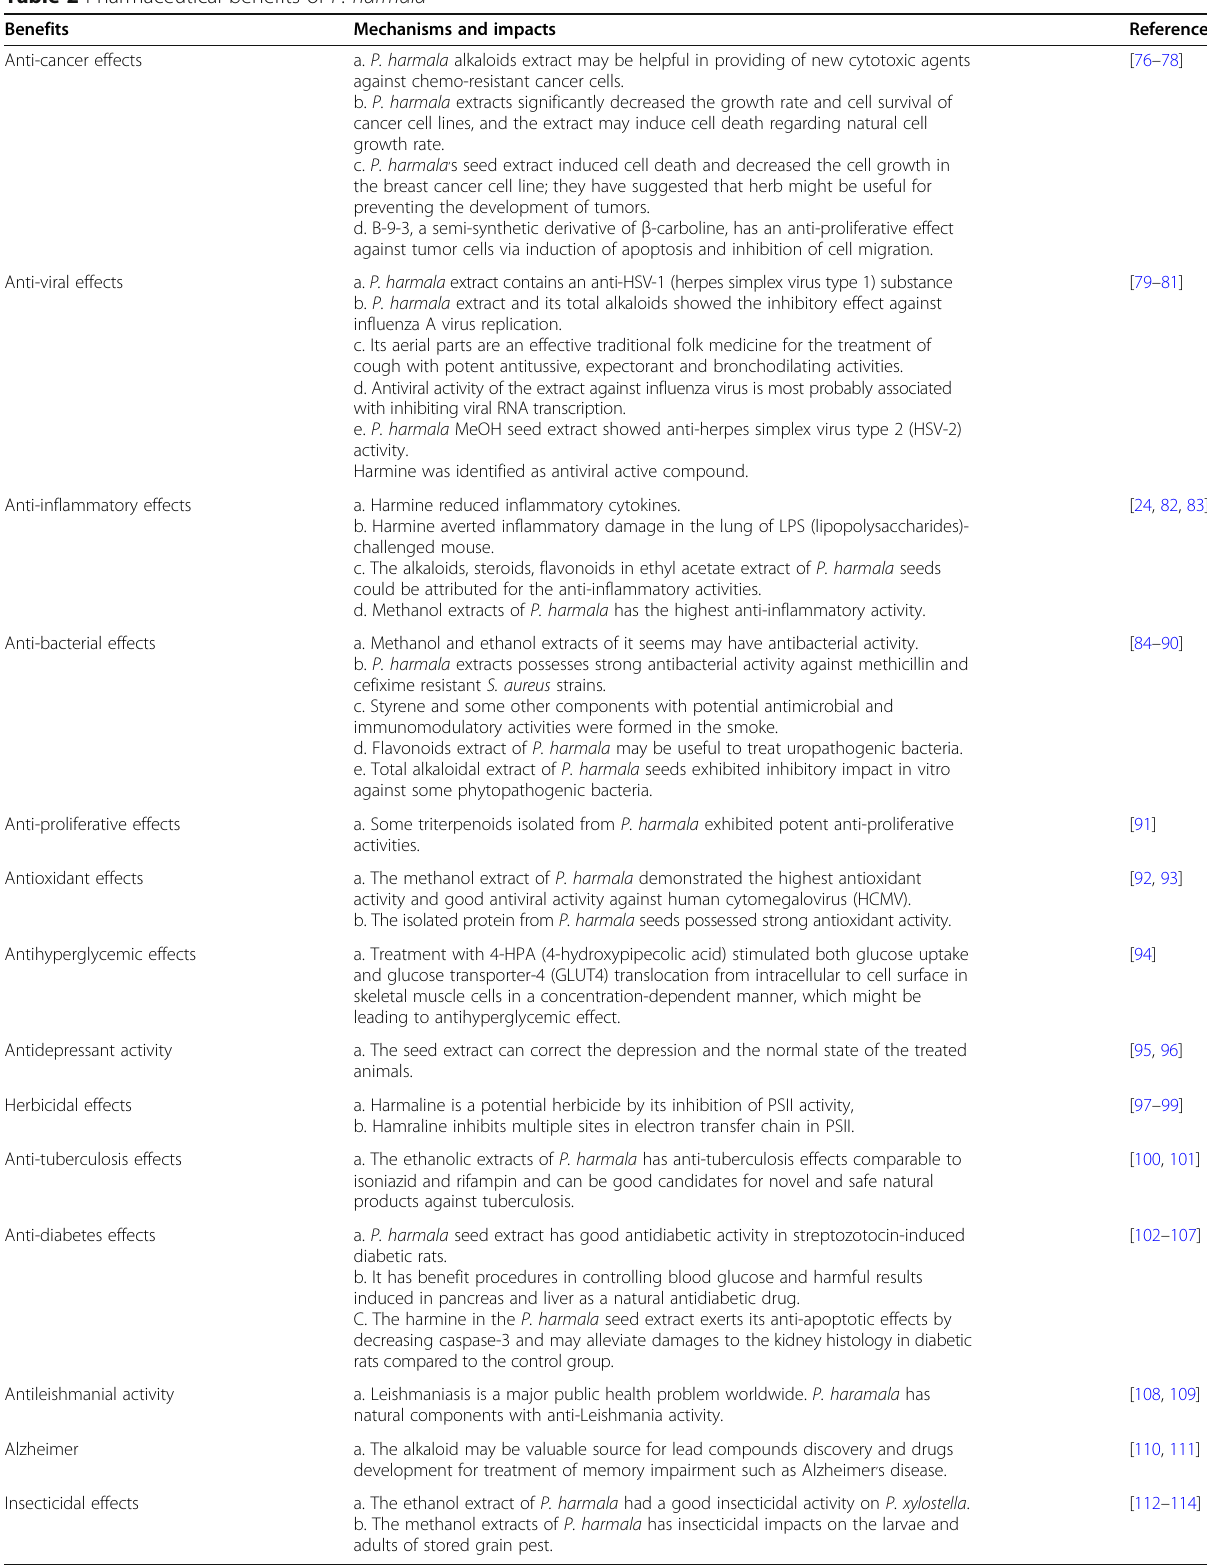
Table 2 Pharmaceutical benefits of P.